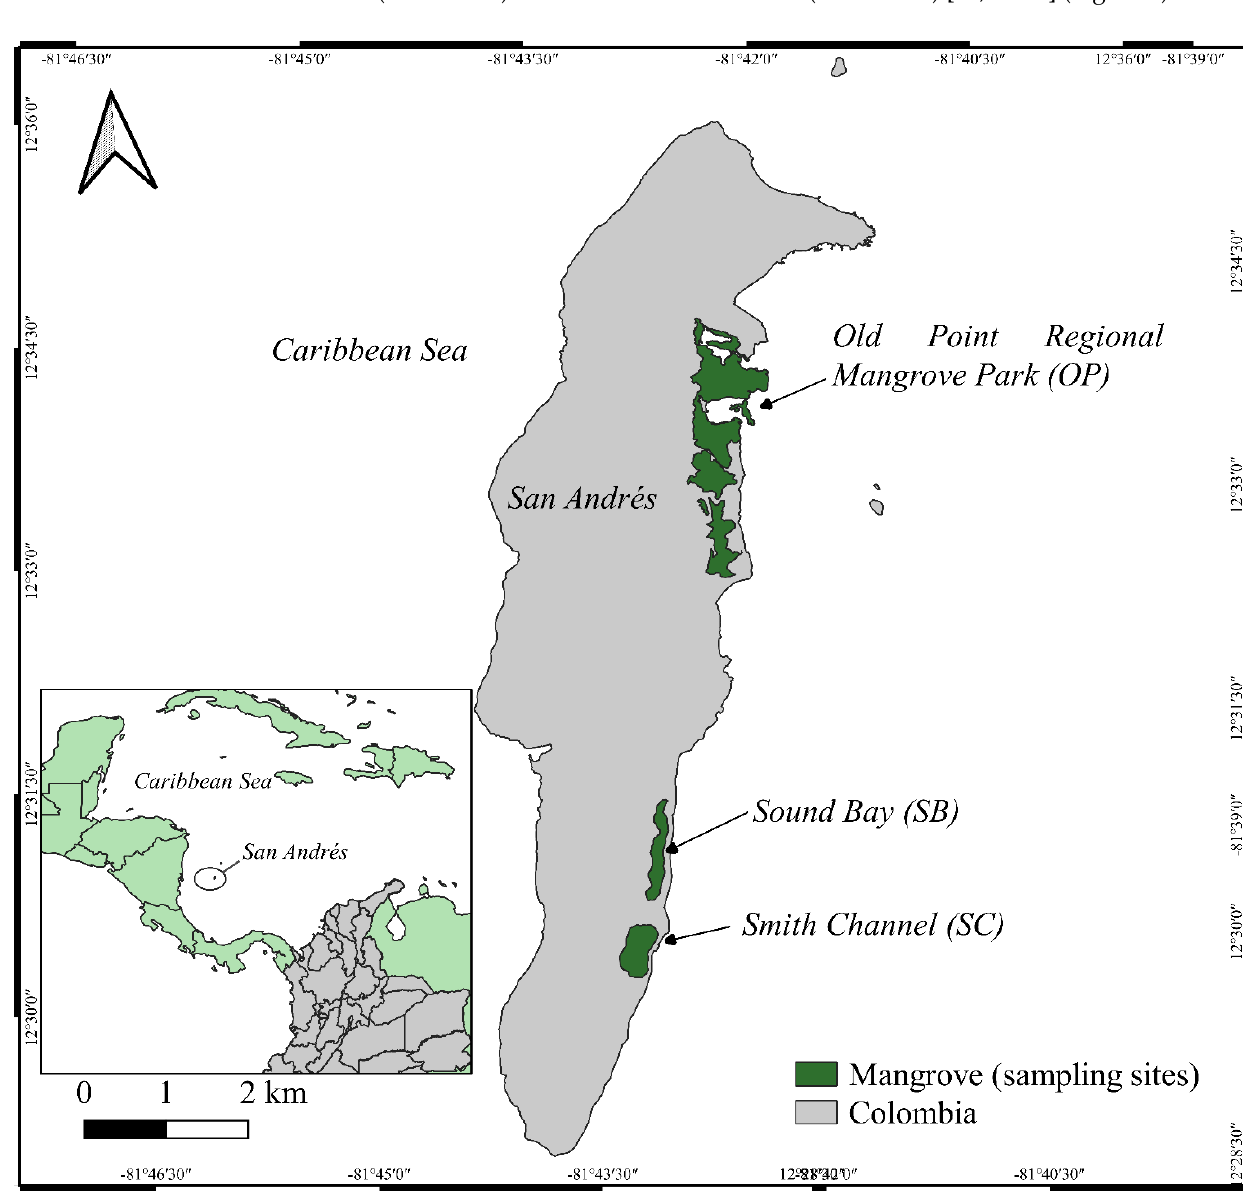
Figure 1. Mangrove forest Old Point (OP), Sound Bay (SB) and Smith Channel (SC) in San Andrés island–Colombia. Old Point is located in the northeast (12 ◦ 34 (cid:48) 00.5 (cid:48)(cid:48) N; − 81 ◦ 42 (cid:48) 19.3 (cid:48)(cid:48) W), has an area of 65 ha [17] and trees 7.9 ± 0.2 m tall and 8.5 ± 0.3 cm DBH [17]. Two types of forest